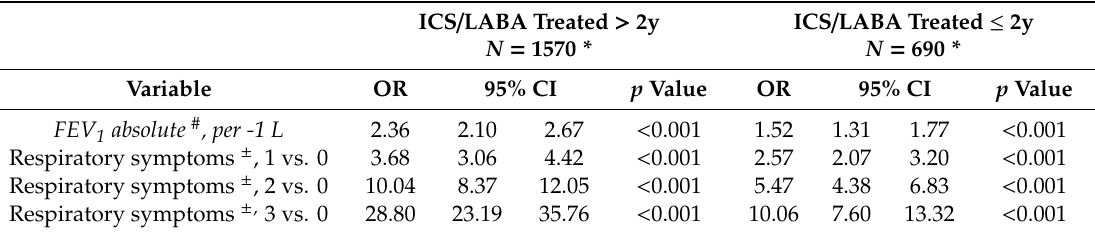
Table 2. Multinomial logistic regression $ for ICS / LABA treatment ( n = 9018) *. ICS/LABA Treated >